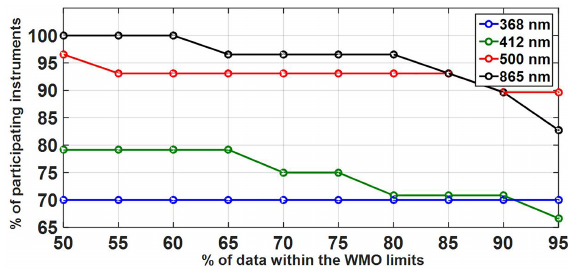
Figure 5. Percentage of instruments that lie within the WMO cri- terion (0.005 + 0 . 01 /m optical depths). The horizontal axis shows the different percentages of measurements within the criterion end- ing at 95%, which is the U95 WMO